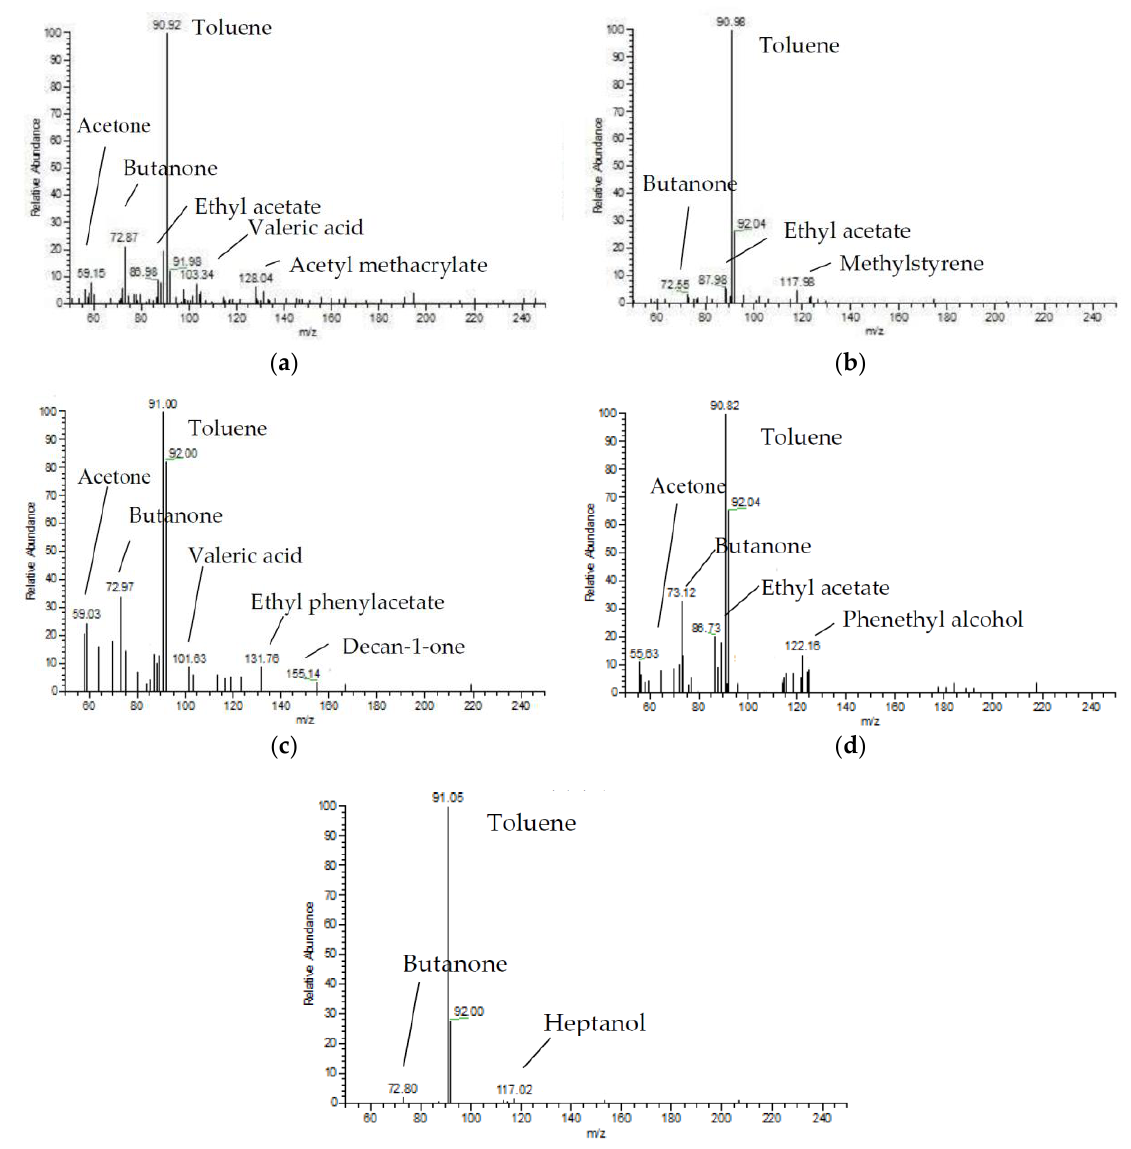
Figure 10. Gas chromatography mass spectroscopy (GC-MS) results from different reactors. ( a ) DBD reactor; ( b ) DBD-catalyst reactor; ( c ) DDBD reactor; ( d ) DDBD-catalyst reactor; ( e ) Reverse-flow DBD-catalyst reactor. Table 3. Main products in different reactors. DBD, dielectric barrier discharge; DDBD, double dielectric barrier discharge.